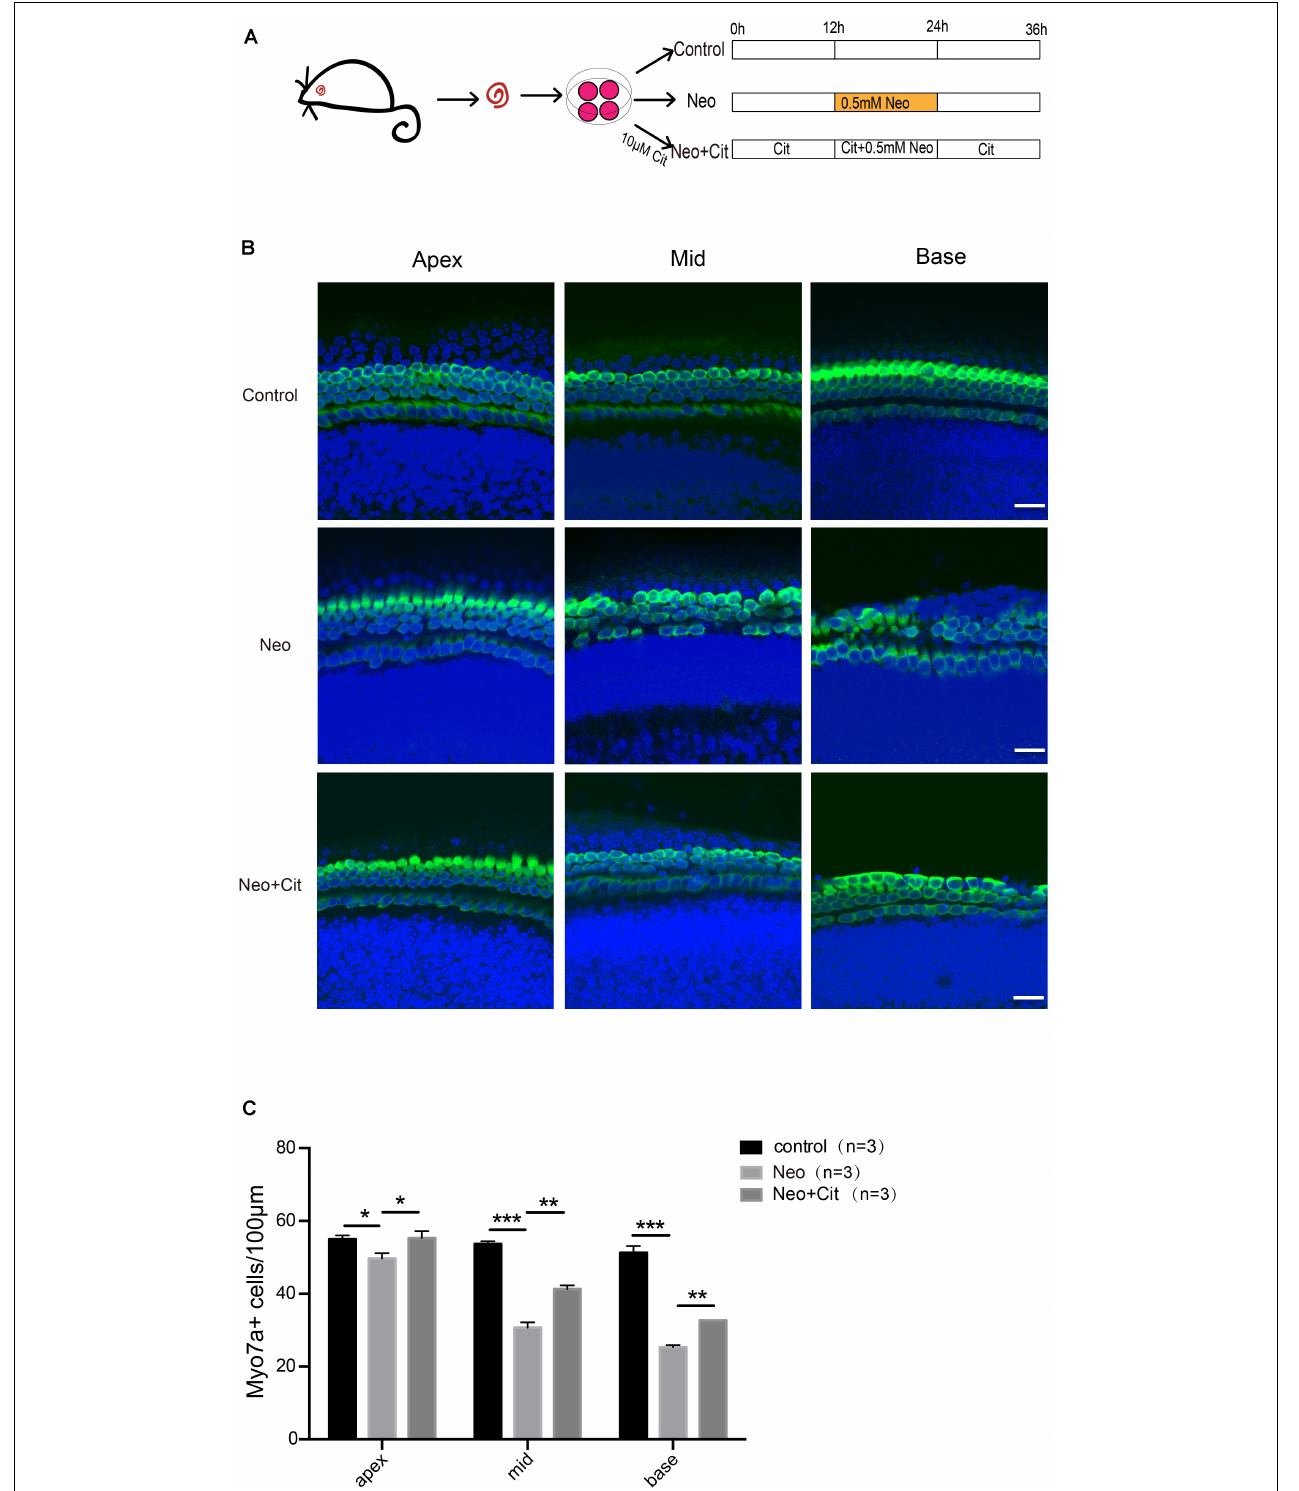
FIGURE 1 | Citicoline protects against apoptosis in cochlear HCs after neomycin injury. (A) Schematic diagram of drug addition in tissue culture. (B) Immunofluorescence staining with Myo7A (green) and DAPI (blue) in the apical, middle, and basal turns of the cochlear explant cultures with different treatments. (C) Quantification of the numbers of Myo7A and DAPI double-positive cells in (B) . Data are shown as mean ± SD. * p < 0.05, ** p < 0.01, *** p < 0.001. Scale bars = 20 µ m.